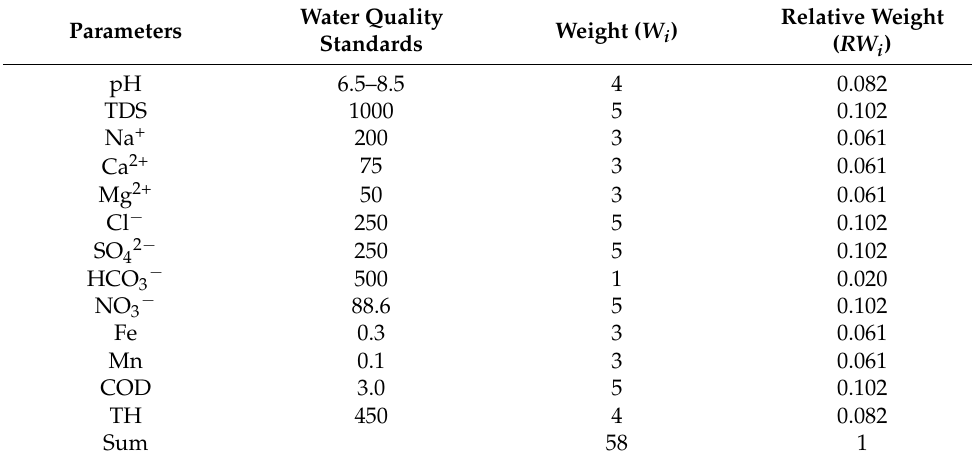
Table 1. Relative weight of physicochemical parameters and water quality standard (all units of the parameters are mg/L except pH).